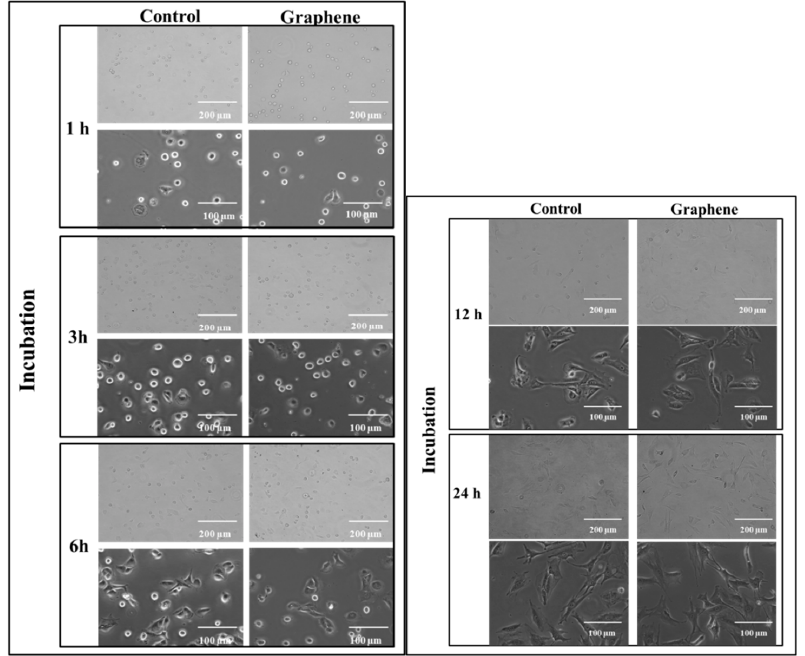
Figure 3. Morphology of BALB 3T3 cells growing on glass and graphene substrate at different time of incubation 1, 3, 6, 12 and 24 h.